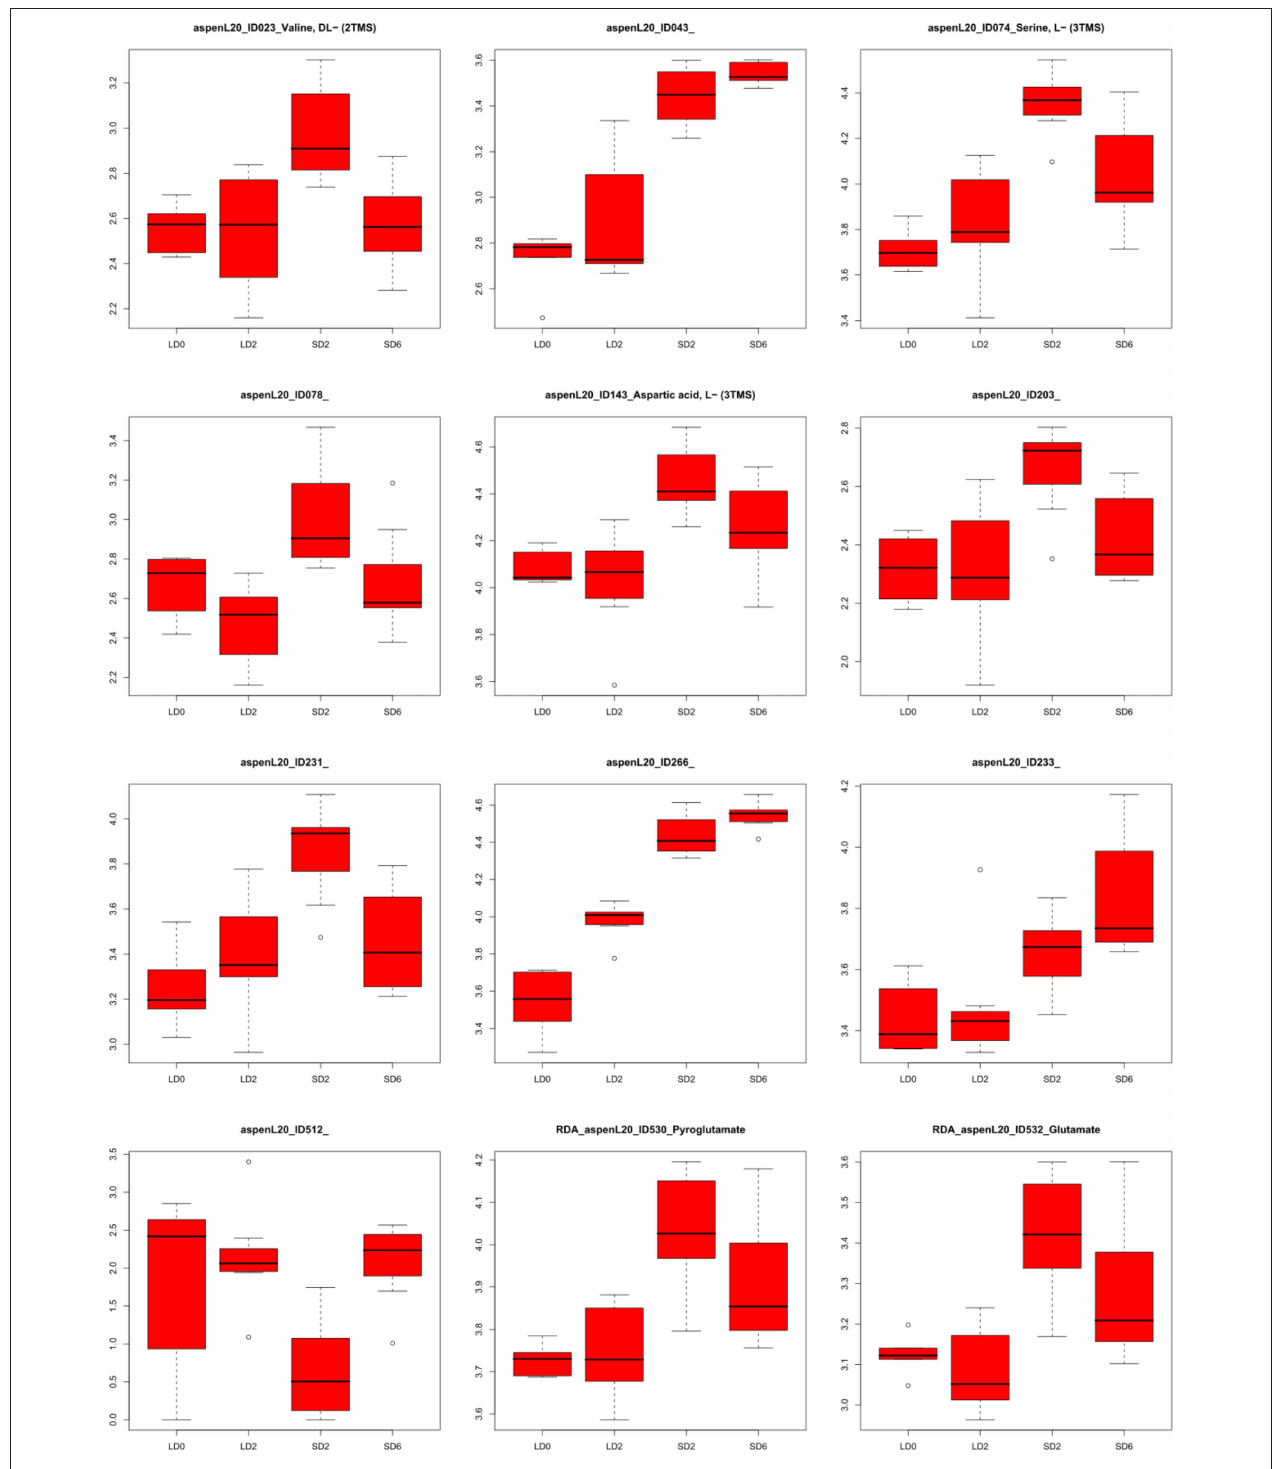
FiGure A2 | Box plots of the 12 metabolites that showed significant changes from a two-way ANOVA. These metabolites were found to be significantly different in relation to our photoperiod treatments. The x -axis